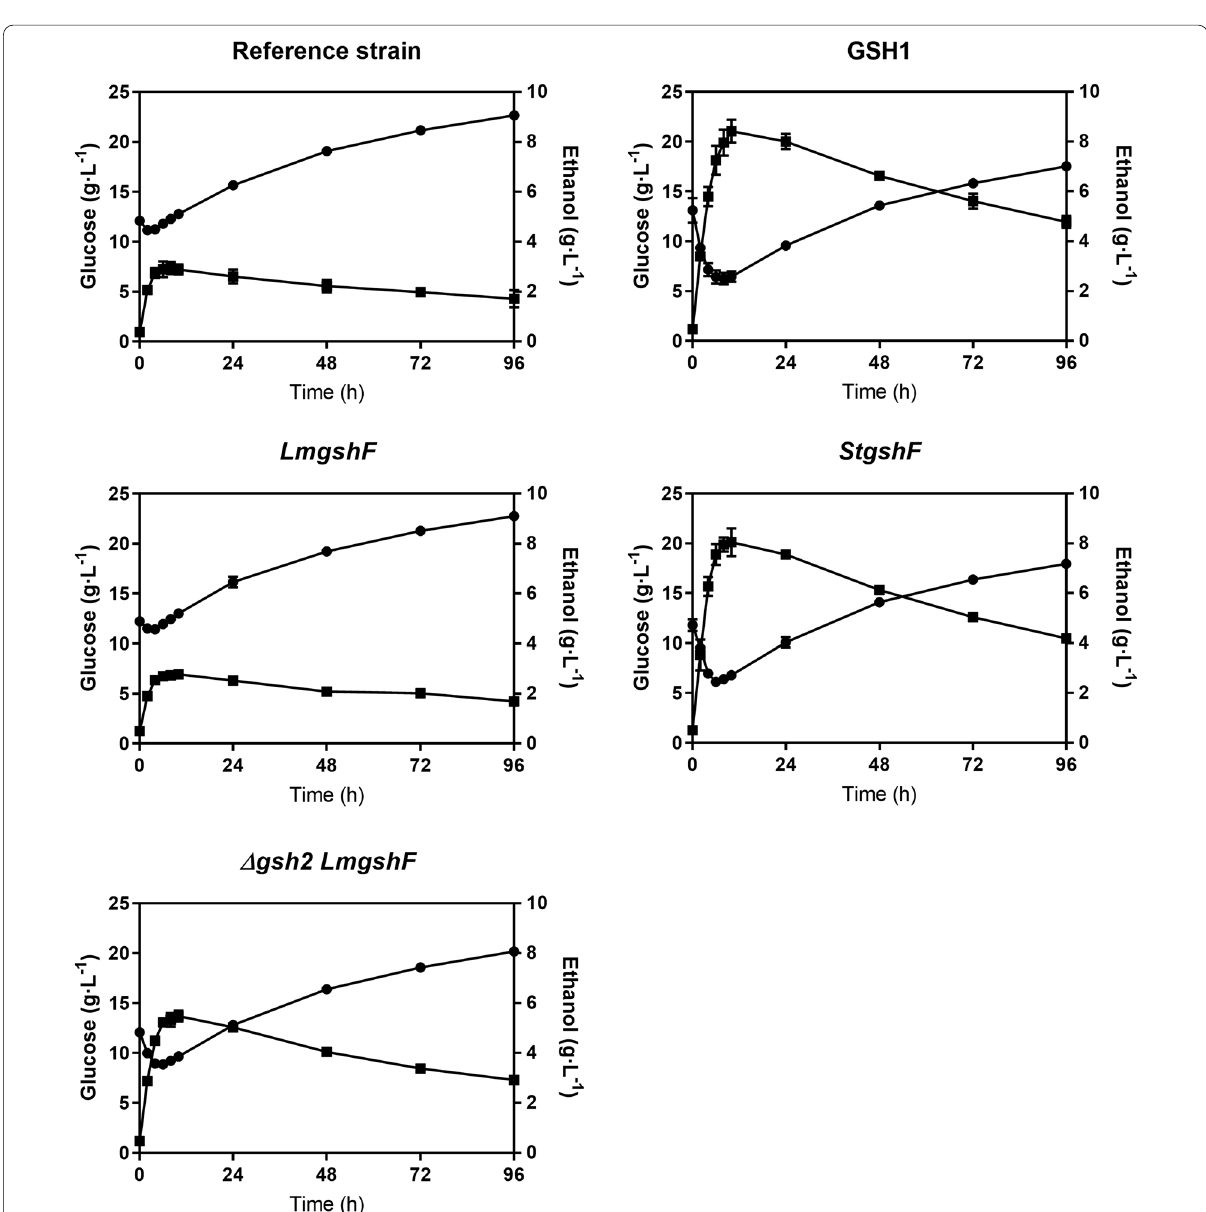
Fig. 3 The time course of glucose (filled circles) and ethanol (filled squares) concentrations with the Saccharomyces cerevisiae strains investigated in the present study with spruce hydrolysate containing 10% WIS content and using the same operating conditions as described in Fig. 3. The data are the means and standard deviation (n =